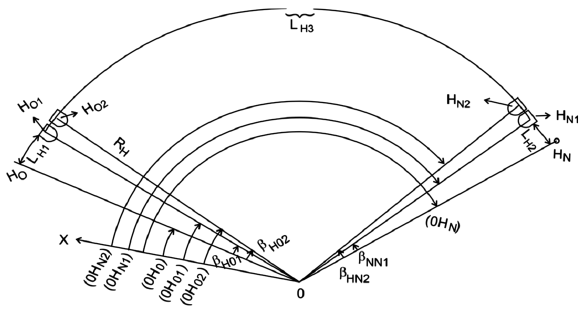
Figure 10. The bearings from O curve centre to intermediate points of seat at first and second curve rows on two-pieces curve